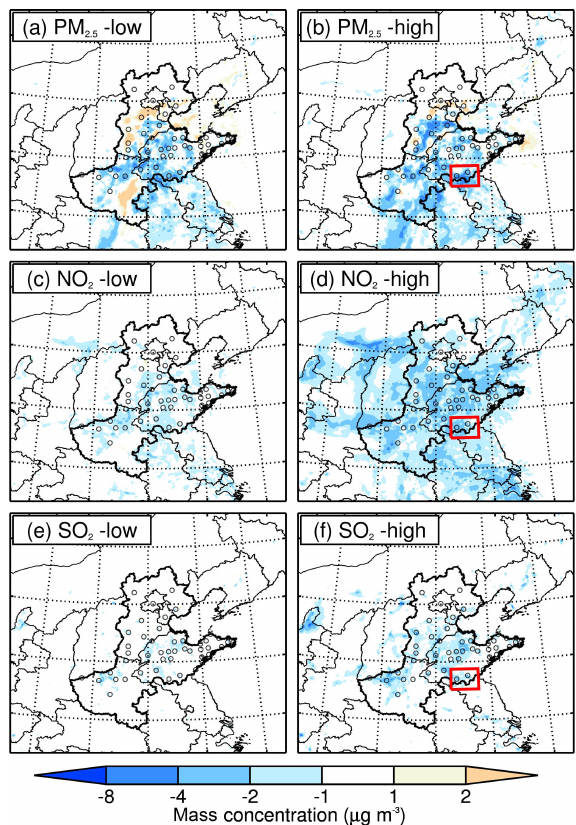
Figure 8. The lower (left panels) and upper (right panels) episode- averaged variations induced by the GLP, including the mass concen- trations (µgm − 3 ) of (a) PM 2 . 5 , (b) NO 2 , and (c) SO 2 . The results refer to the spatial variations between the REF case and the SEN- GLP case